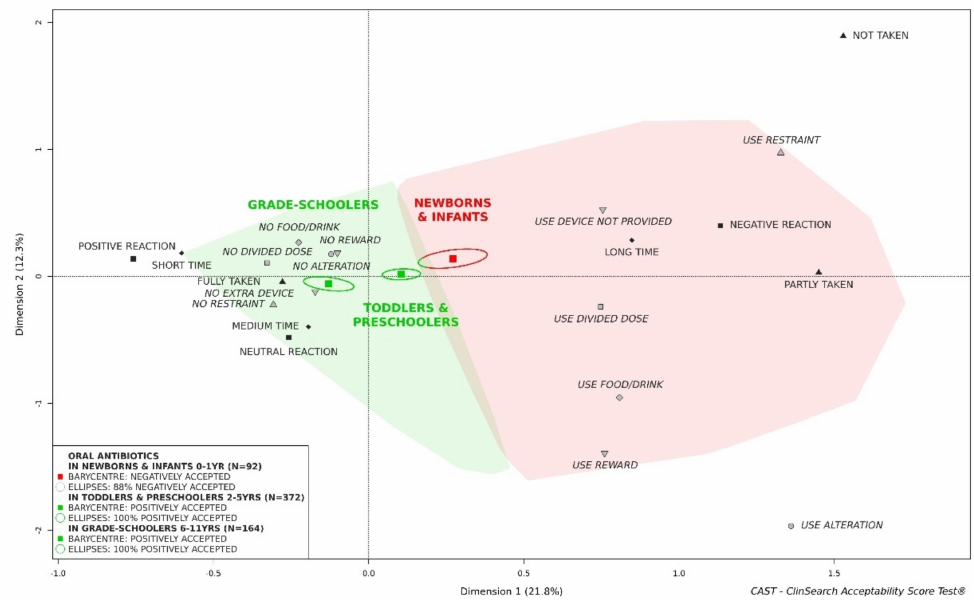
Figure 3. Acceptability of oral antibiotics in newborns and infants, toddlers and preschoolers, and